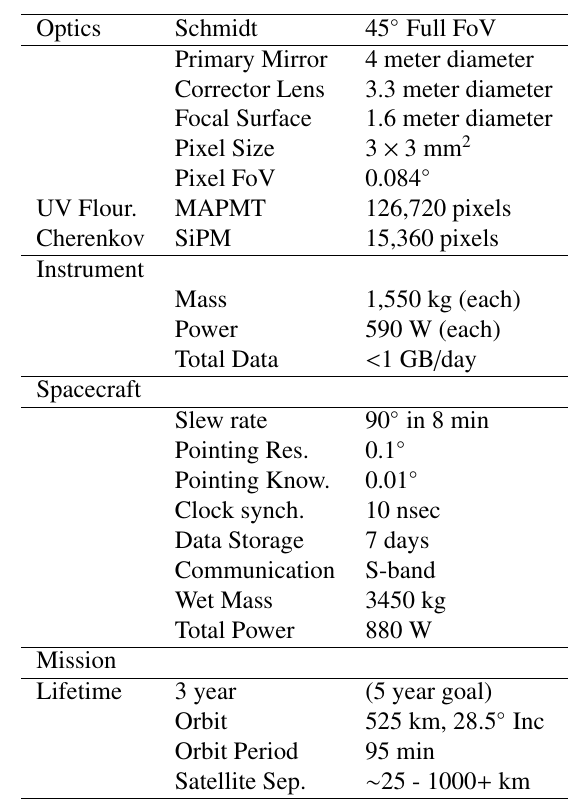
Table 1. POEMMA Instrument, Spacecraft, and Mission Specifications